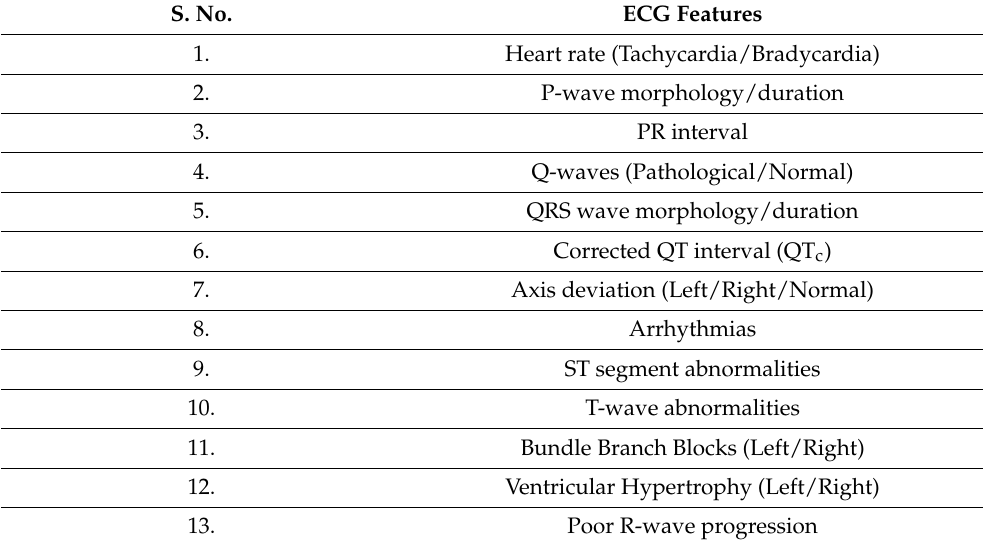
Table 1. ECG details obtained from medical